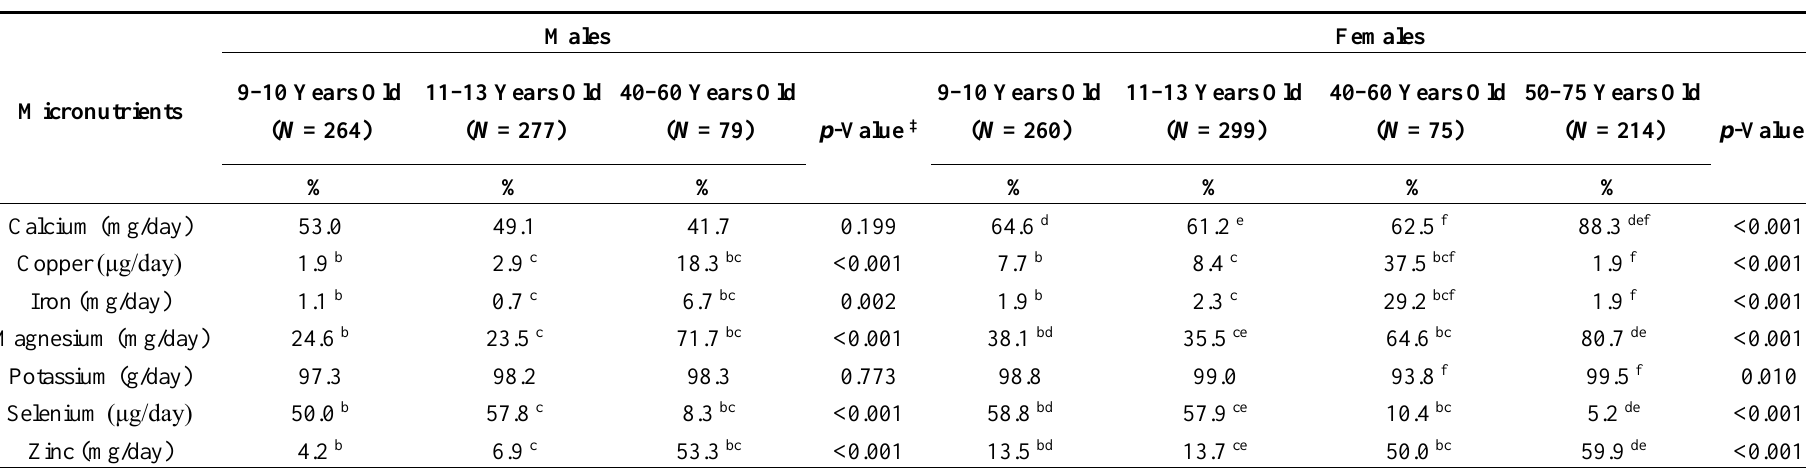
Table 4. Percentages of children, middle-aged adults and postmenopausal women in Greece with usual dietary intakes below estimated average requirement (EAR), presented by sex and age